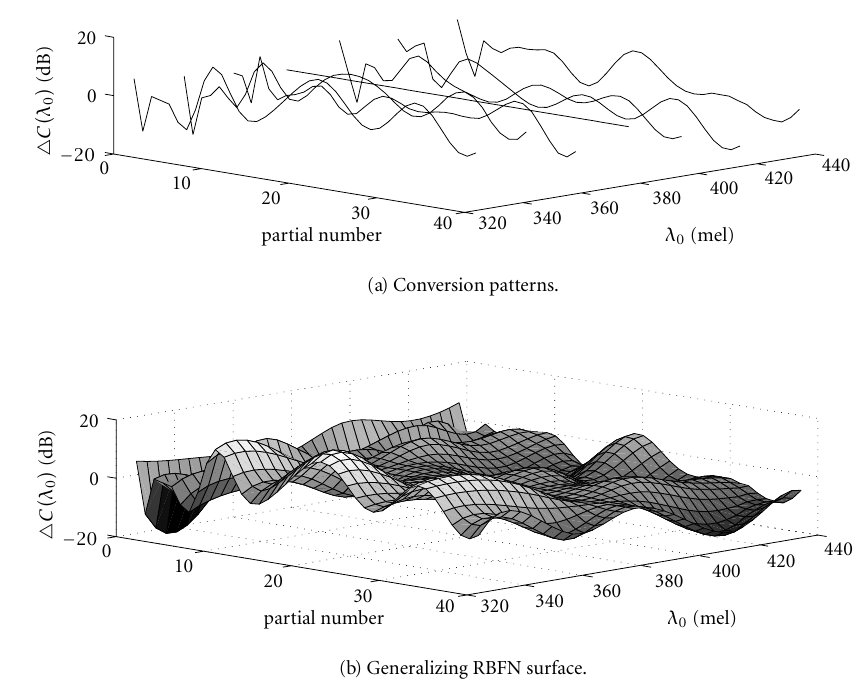
Figure 5: (a) The 7 waveform preserving conversion patterns resulting from 7 sax notes. (b) Interpolating surface provided by the RBFN.